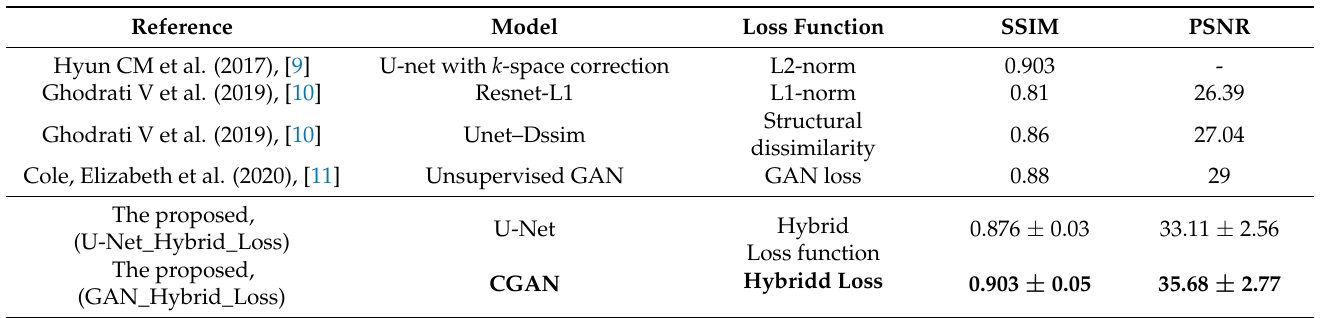
Table 5. Comparison of the evaluation results against the latest AI research works for MRI image